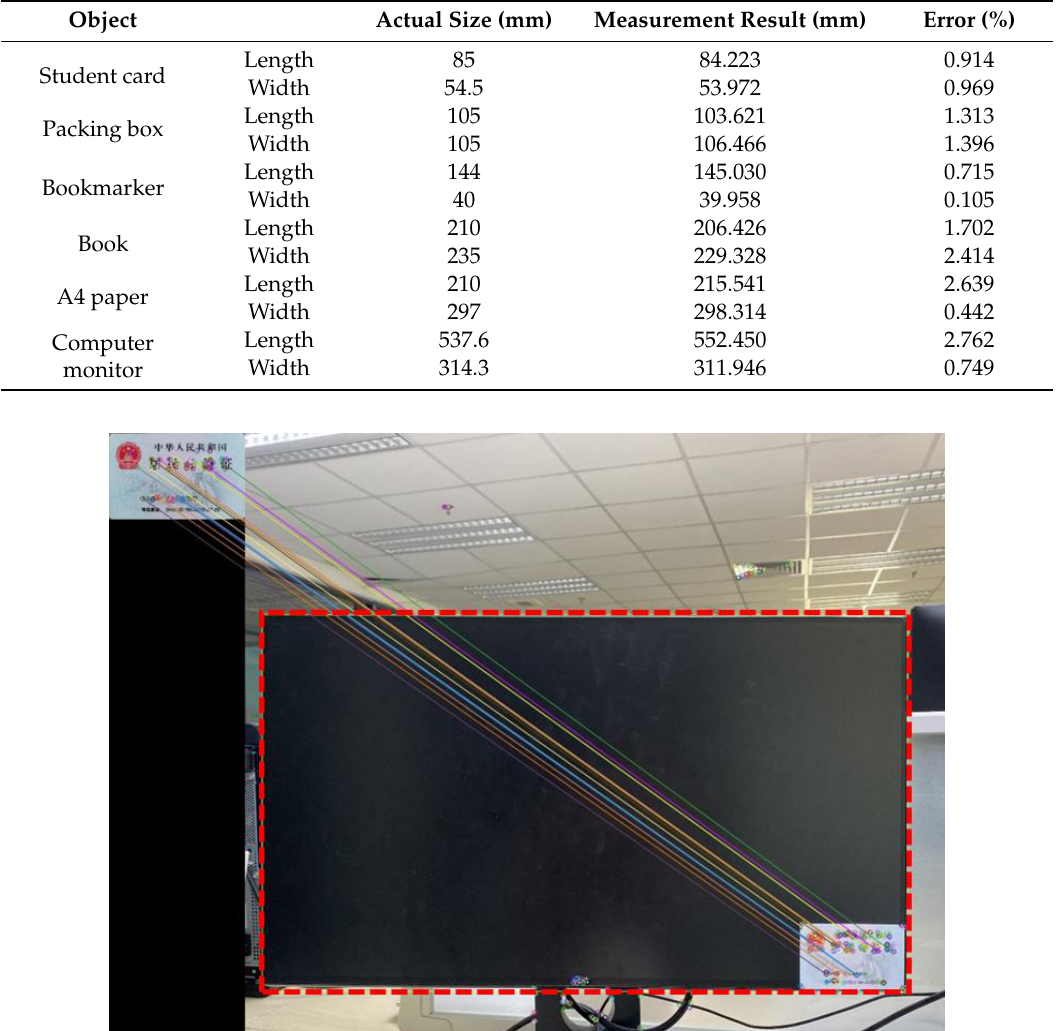
Table 5. The vision-based measurement results with SR-SYBA.